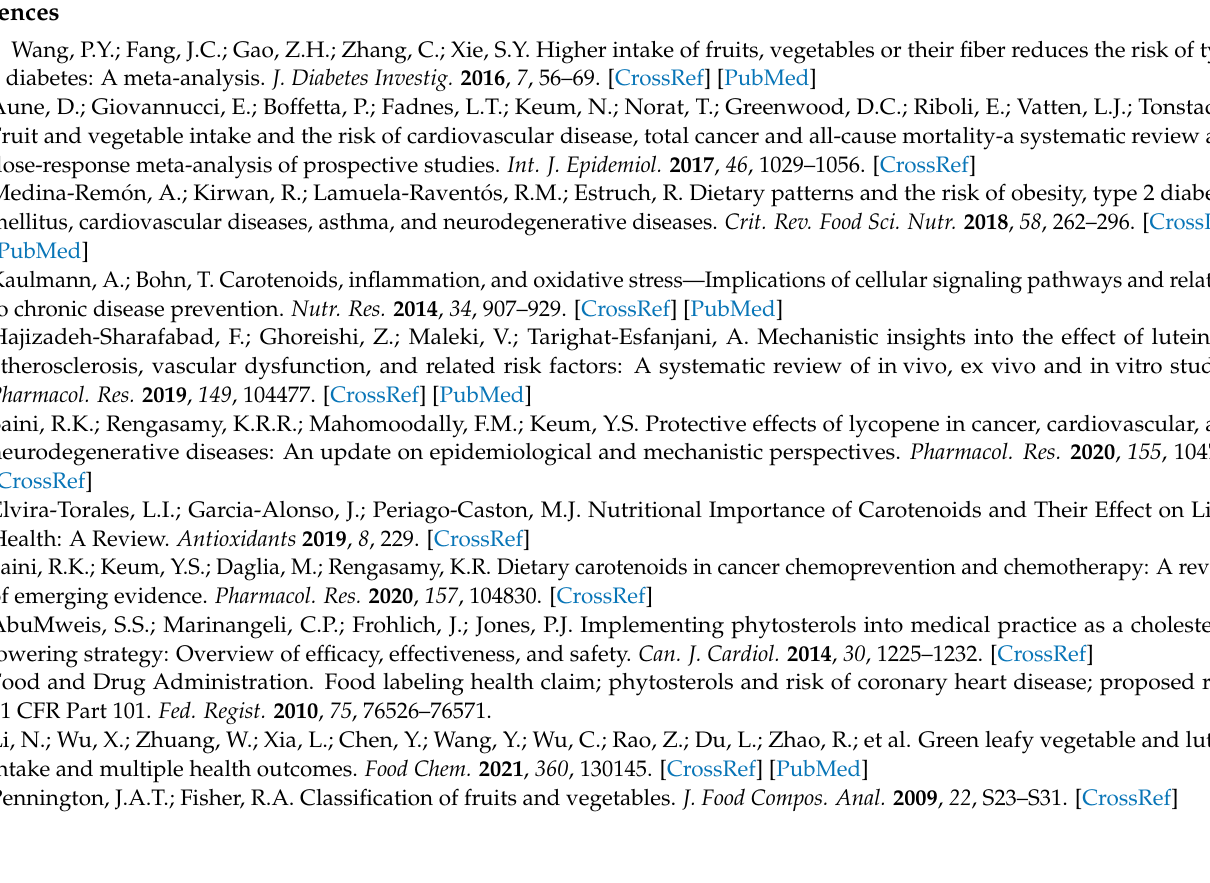
Figure S2: Outline of Methods Used for the Hydrolysis and Silylation of Sterols for GC-MS, Figure S3: A characteristic mass fragmentation pattern of β -Sitosterol (trimethylsiloxy (TMS) derivative) ob- served in the present investigation, Figure S4: The characteristic GC-MS-fragmentation pattern of phytosterols identified in studied GLVs, Table S1: Method analytical and validation parameters for LC-SIM-MS analysis of carotenoids and tocopherols, Table S2: Method analytical and validation parameters for GC-MS analysis of